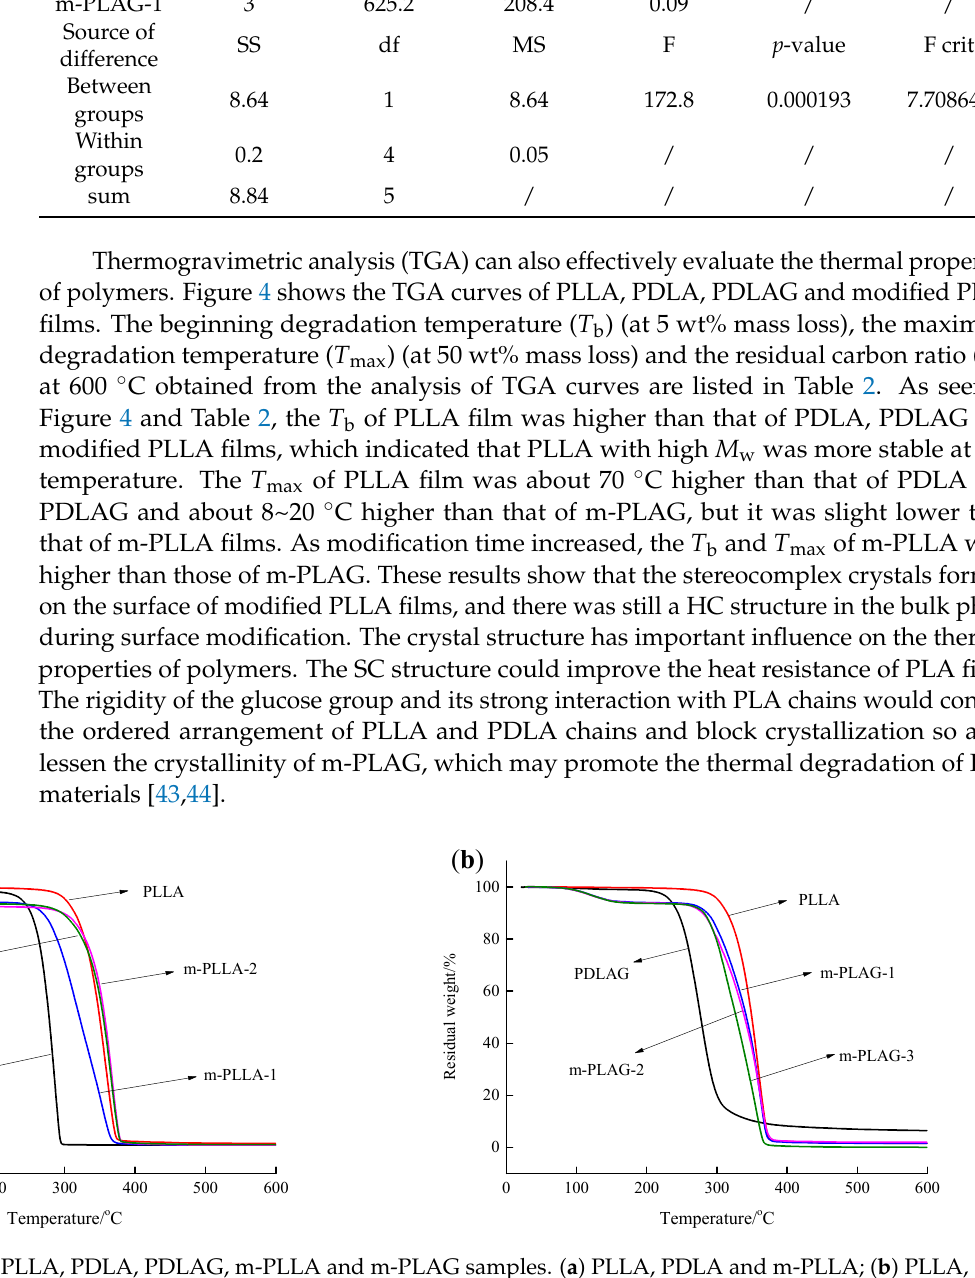
Figure 4. TGA curve of PLLA, PDLA, PDLAG, m − PLLA and m − PLAG samples. ( a ) PLLA, PDLA and m − PLLA; ( b ) PLLA, PDLAG and m − PLAG.